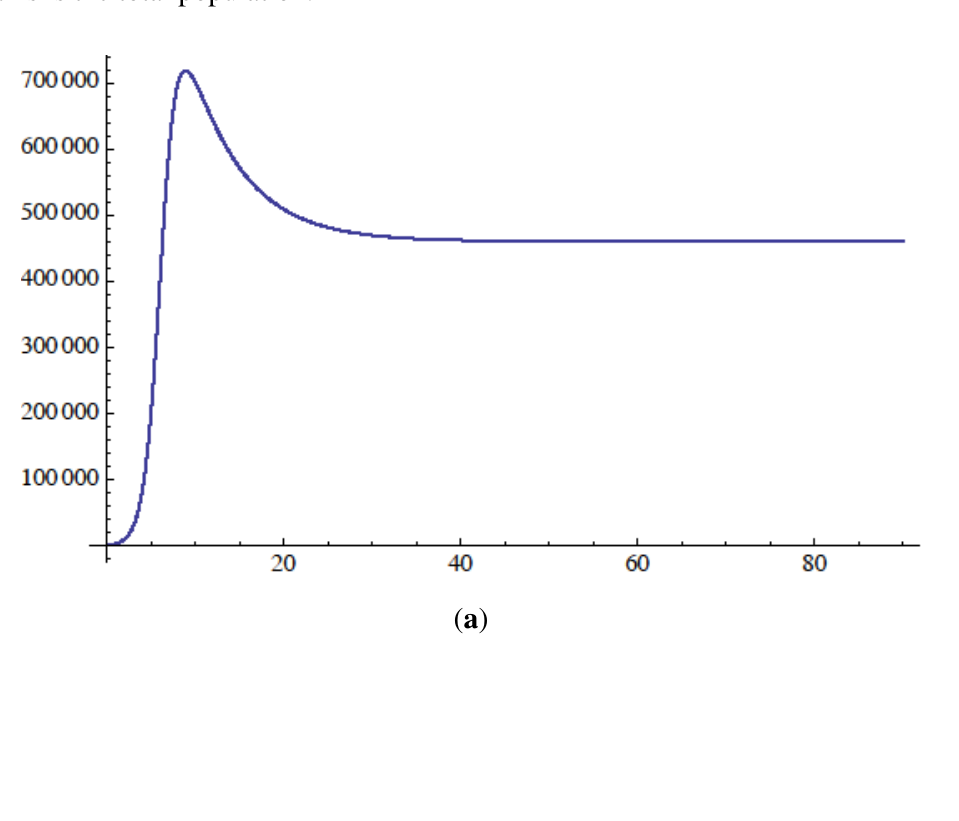
Figure 6. Simulations of the differential equation model. (a) Susceptible males; (b) Infected males; (c) Susceptible females; (d) Infected females. The x- axis represents time in days and the y-axis is the total